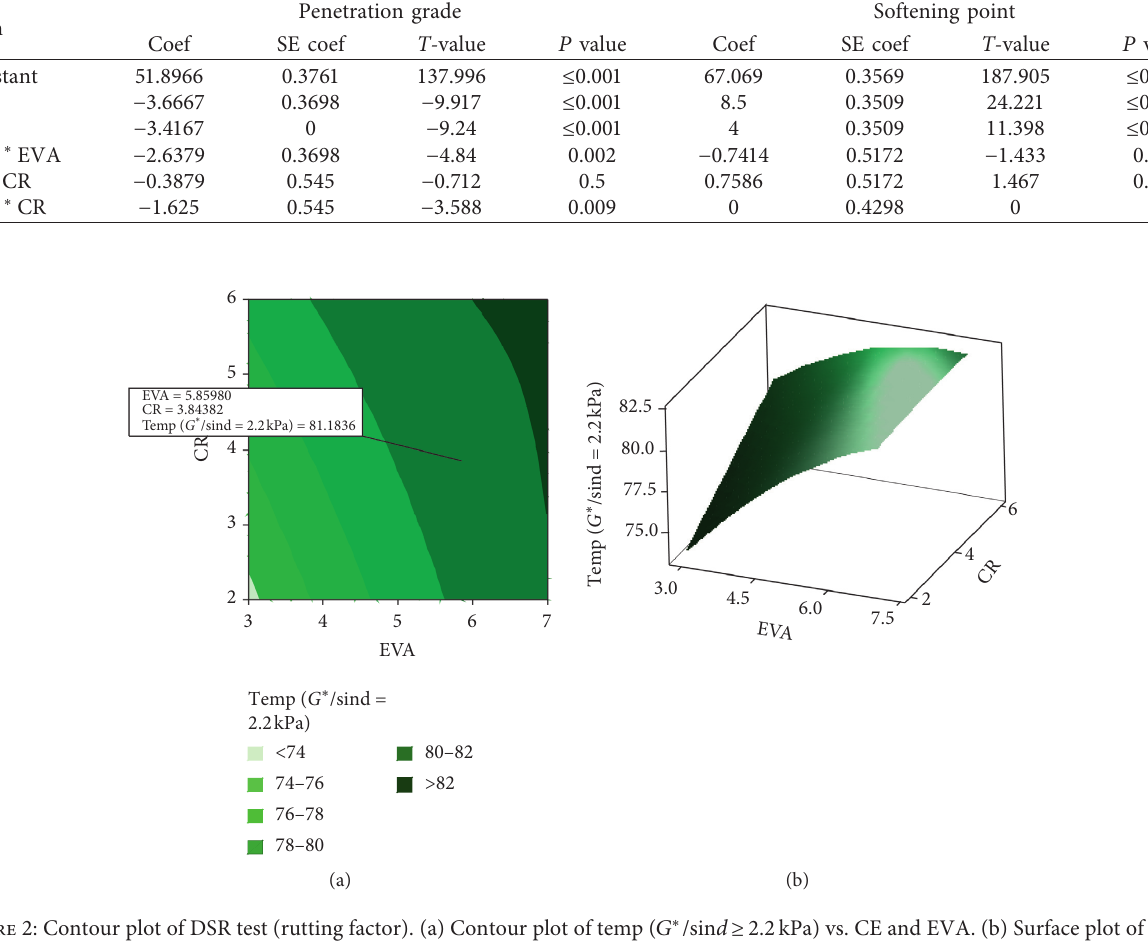
Table 4: Values of regression coefficients calculated for penetration grade and softening point tests.